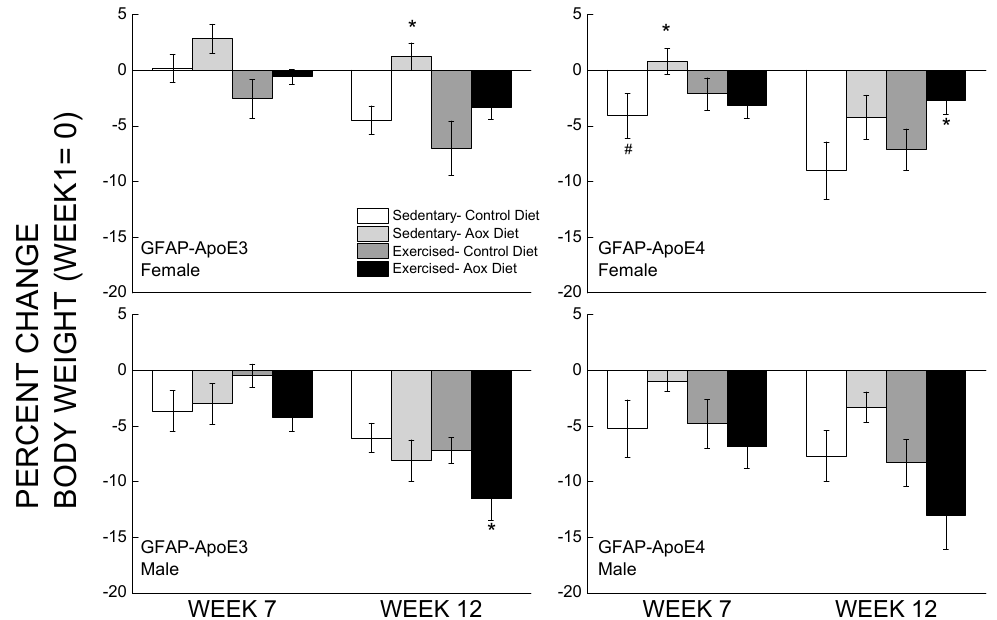
Figure 1. Minimal effects of exercise and/or antioxidant regimen over time on body weights of middle-aged GFAP-APOE3 and GFAP-APOE4 male and female mice (mice expressing the human apolipoprotein (Apo) E3 or E4 under glial fibrillary acidic protein (GFAP) promoter control). Each value represents mean ± SEM, n = 5–16 for body weights, and n = 3–7 for food intake. * p < 0.05 vs. sex- and strain-matched Sedentary-Control (Sed-Con) groups; # p < 0.05 comparing sex-matched Sed-Con GFAP-ApoE3 and GFAP-ApoE4.